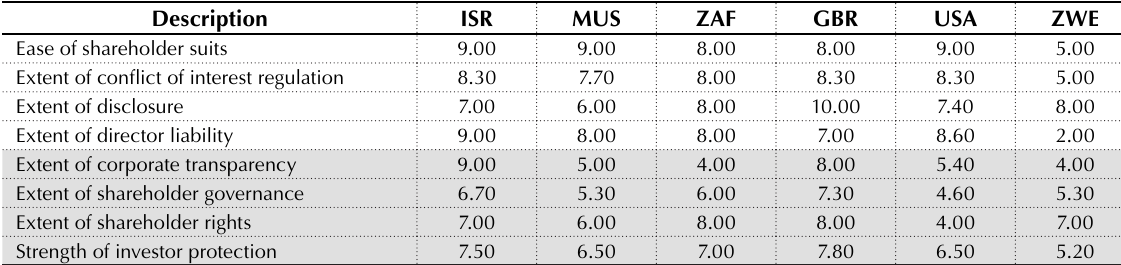
Table 3. Investor Protection Indices for selected countries as of 2016